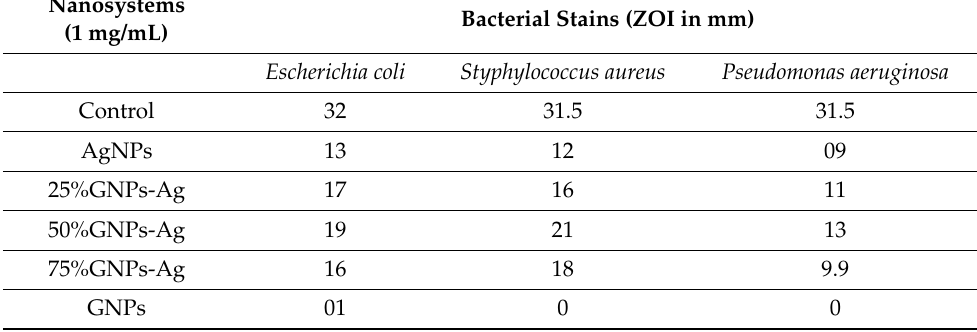
Figure 10. Proposed mechanism of bacterial cell death induced by Ag-GNPs nanocomposites. 2.6. Photocatalytic Activity The photocatalysis of methylene blue (MB) was recorded under visible light by uti- lizing AgNPs, GNPs and (Ag) 1−x (GNPs) x as nanocatalysts that dye degraded fully in 75 min after irradiating to visible light (Figure 11). Degradation of MB under visible light irradiation was recorded by the relative intensity of the UV-Vis spectra at the highest ab- sorption peak at 667 nm (Figure 12).